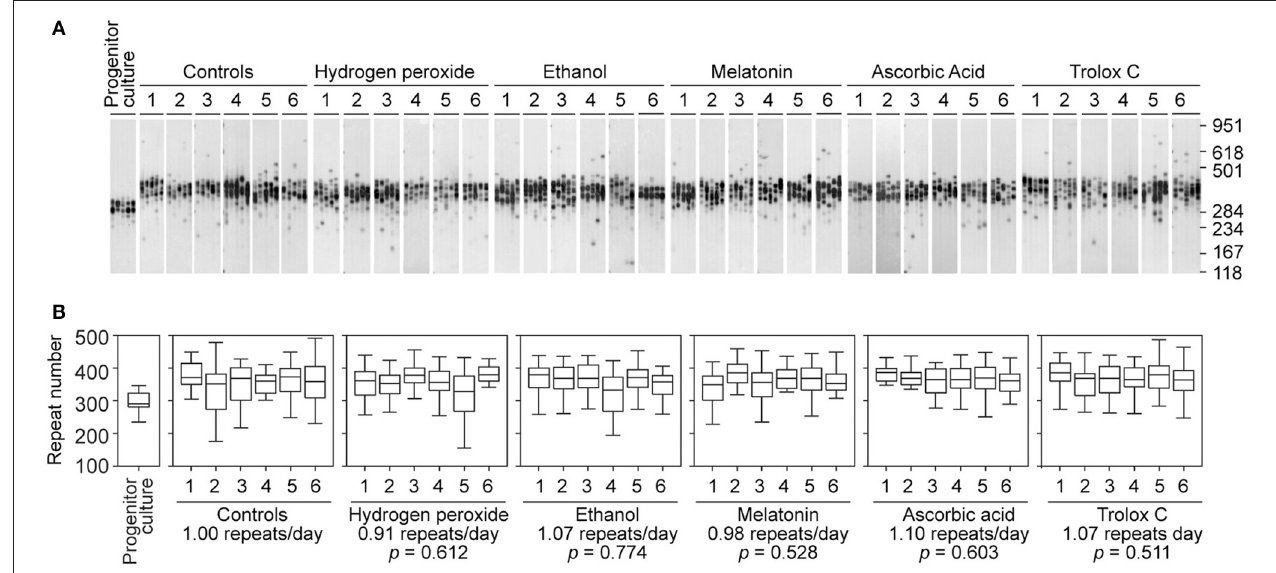
FIGURE 3 | Continuous treatment with antioxidant molecules does not prevent repeat size expansions in a cell culture model system of unstable CAG • CTG repeats. (A) Representative SP-PCR analyses of the expanded CAG • CTG trinucleotide repeat in D2763Kc2 cells cultured for 73 population doublings (corresponding to 68 to 73 days) in the presence of hydrogen peroxide, ethanol (control solvent) or three different antioxidants. Six replicate D2763Kc2 cultures (1 to 6) were analyzed. The progenitor culture from which all cells were derived at day zero is also shown. The scale on the right displays the molecular weight markers converted into CTG repeat numbers. (B) The boxplots show the degree of repeat length variability in treated and control cells at the end of the treatment. None of the treatments tested resulted in a significant change of the repeat expansion rate. p- values are indicated (Kruskal-Wallis test for multiple